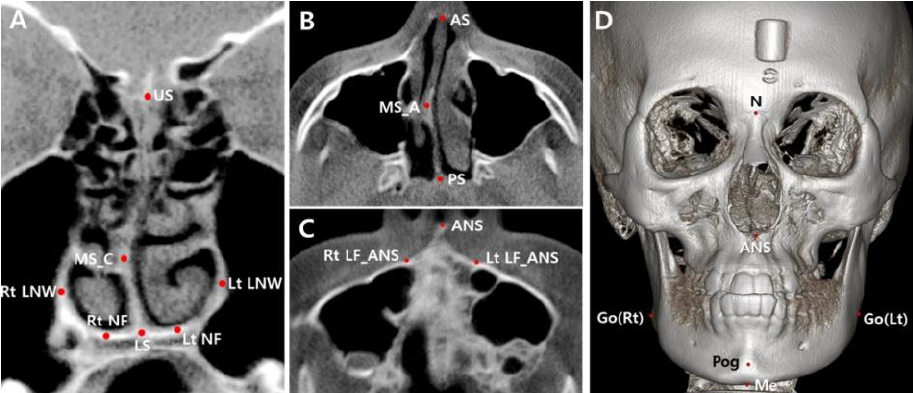
Figure 3. The 3-dimensional landmarks. ( A ) Nasal landmarks on the coronal section passing through the most deviated point in the nasal septum. ( B ) Nasal landmarks on the axial section passing through the most deviated point in the nasal septum. ( C ) Maxillary landmarks on the axial section passing through ANS. ( D ) Mandibular landmarks on the frontal view. Rt, right; Lt, left; US, upper septum; MS_C, middle septum_coronal; LS, lower septum; LNW, lateral nasal wall; NF, nasal floor; AS, anterior septum; MS_A, middle septum_axial; PS, posterior septum; ANS, anterior nasal spine; LF_ANS, lateral fossa_ANS; N, nasion; Pog, pogonion; Me, menton; Go, gonion.